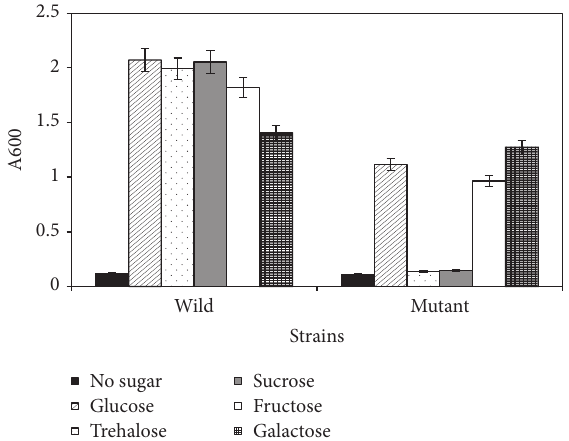
Figure 1: Growth of wild type C. perfringens ATCC 13124 and the mutant 13124 GR in minimal medium with different sugars. Error bars = standard deviation.